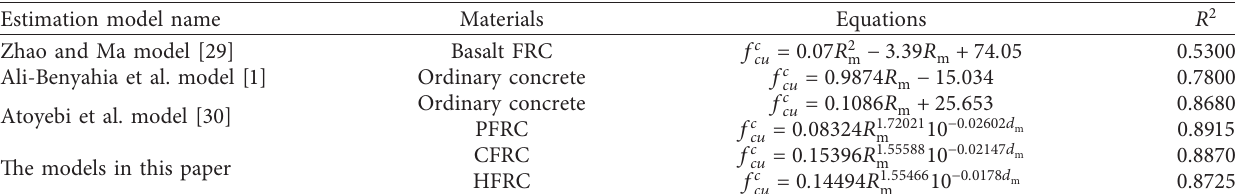
Table 9: Models for estimation of in-place concrete compressive